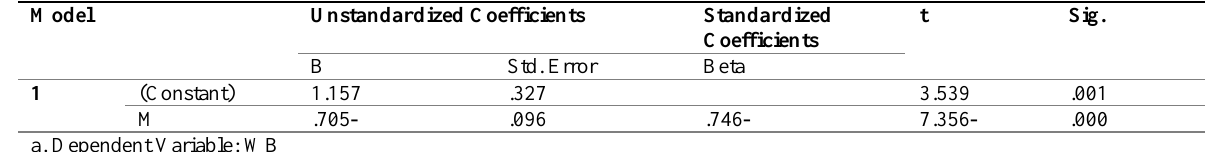
Table 12: Results of Linear Regression between Mindfulness and Workplace Bullying